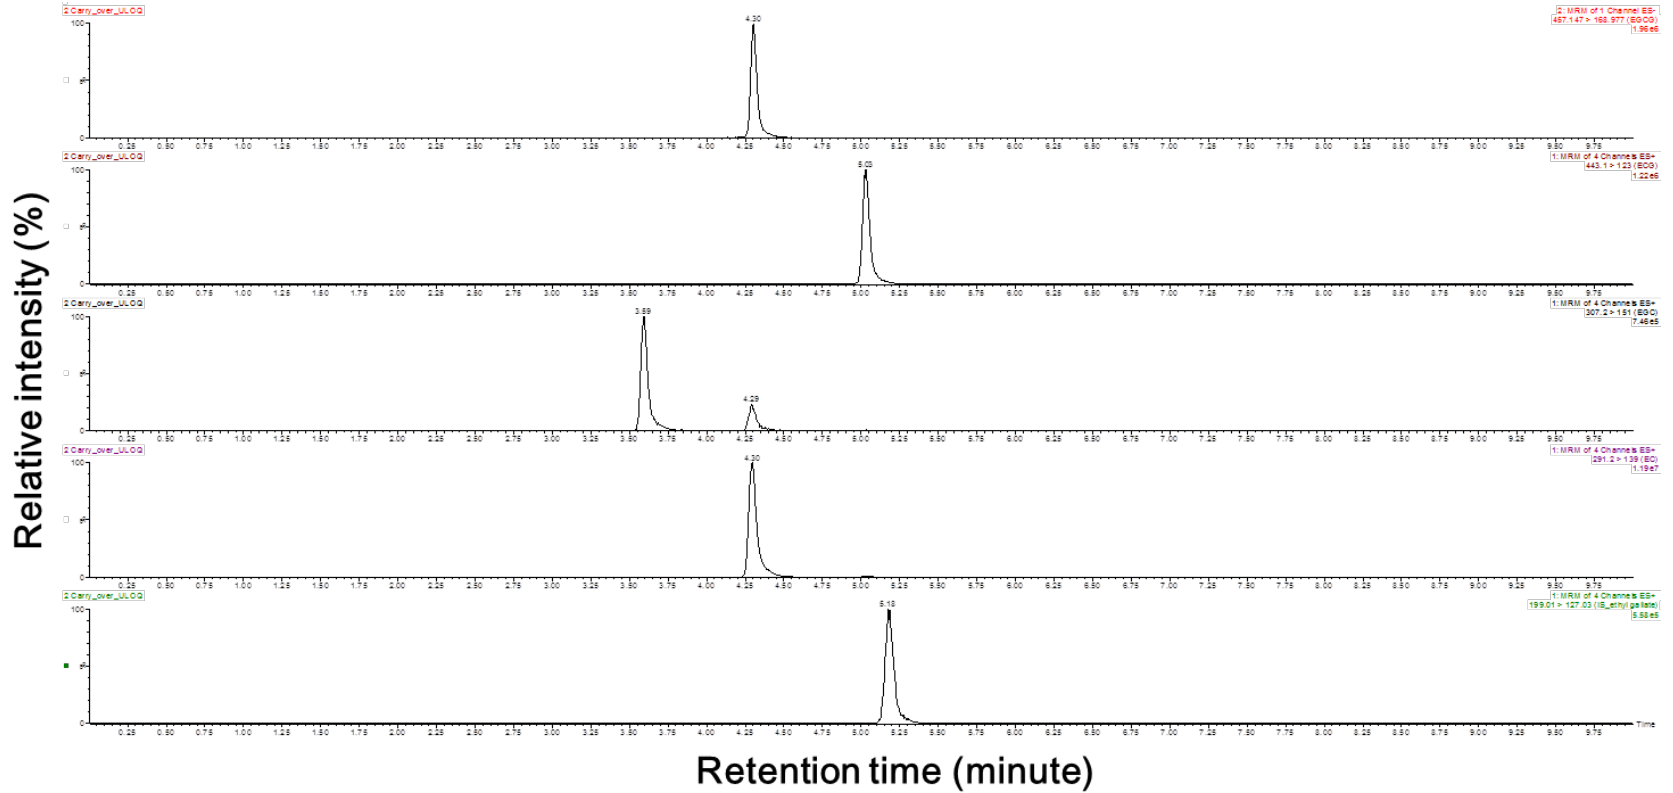
Figure 1. Chromatograms of epigallocatechin-3-gallate, epicatechin-3-gallate, epigallocatechin, epicatechin and ethyl gallate. EGCG, epigallocatechin-3-gallate; ECG, epicatechin-3-gallate; EGC, epigallocatechin; EC, epicatechin. The selected chromatographs were representative of the highest quantitation limit.